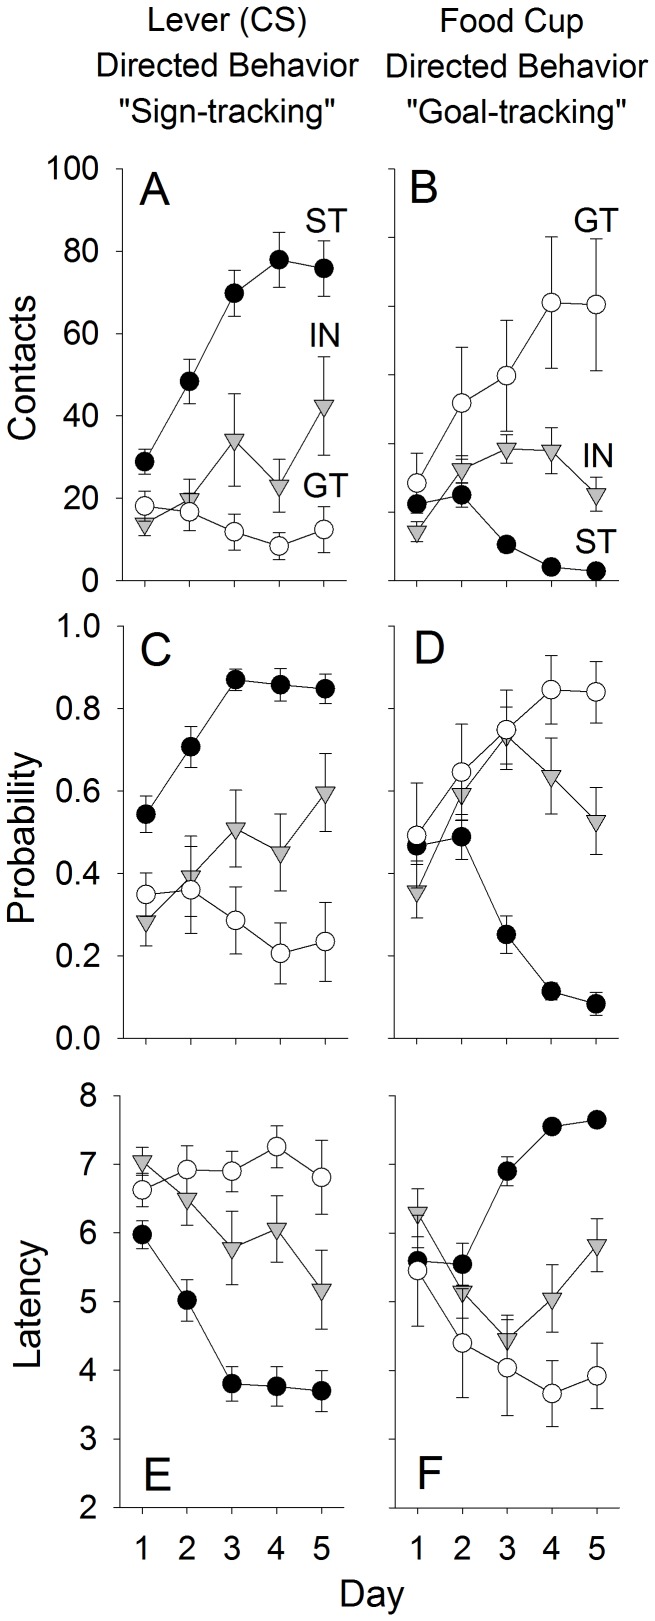
Pavlovian Conditioned Approach (PCA).Rats (n = 47) were classed as sign-trackers (ST), intermediates (IN) or goal-trackers (GT) based on CS-evoked behaviors during 5 days of Pavlovian training. Values represent mean (± SEM) number of lever deflections (panel A), food cup entries (panel B), probability of approaching the lever (panel C), or food cup (panel D), and latency to contact the lever (panel E) or make a food cup entry (panel F).